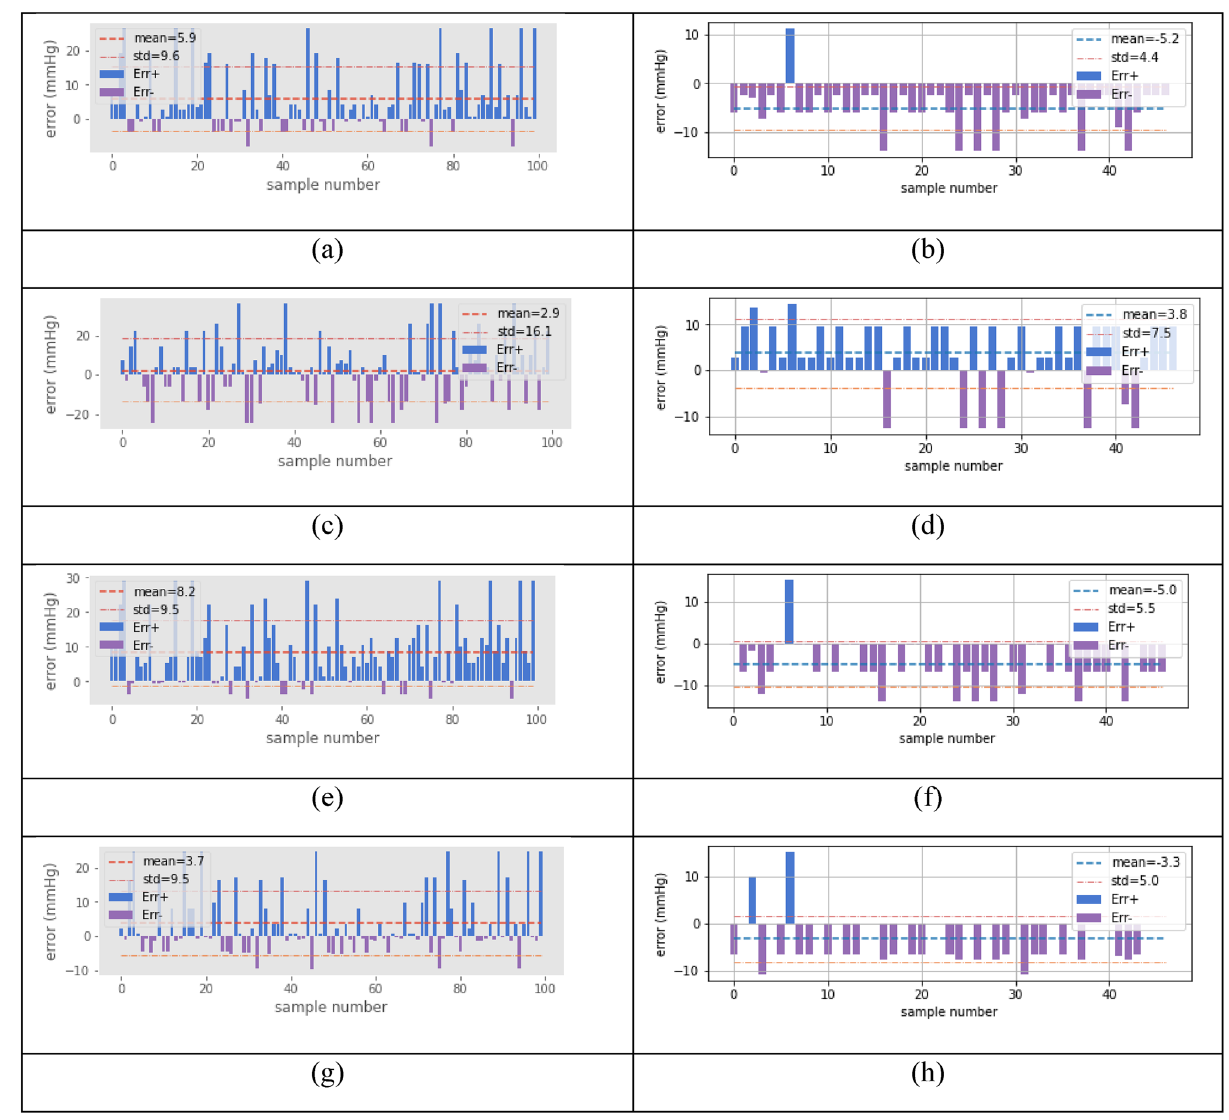
Figure 6. Error in units of pressure, left column, reveals the performance using all measures, and the right column uses restricted data. First line ( a ), ( b ) linear regression, second line ( c ), ( d ) ridge regression, third line ( e ), ( f ) SVM, and fourth line ( g ), ( h ) Random Forest.